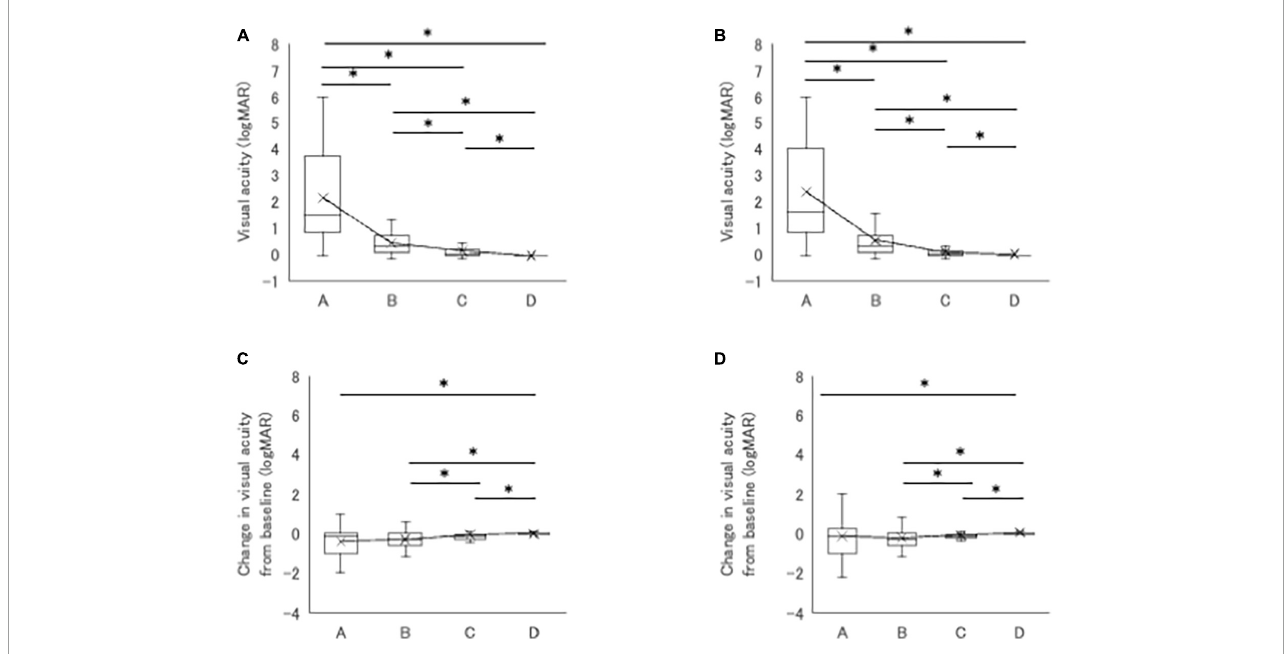
FIGURE3 (A,B) Comparison of logMAR VA between four groups classified by VA at 5 (A) and 10 years (B) . Significant differences are observed between groups A, B, C, and D. (C,D) Comparison of changes in logMAR VA from baseline between four groups at 5 (C) and 10 years (D) . Significant differences are observed between group D and group A, B or C. Groups classified by VA: group A ( < 0.1, n = 42), group B (0.1 to < 0.5, n = 57), group C (0.5 to < 1.0, n = 40), and group D ( ≥ 1.0, n = 49). ∗ P < 0.05 by Steel-Dwass test.